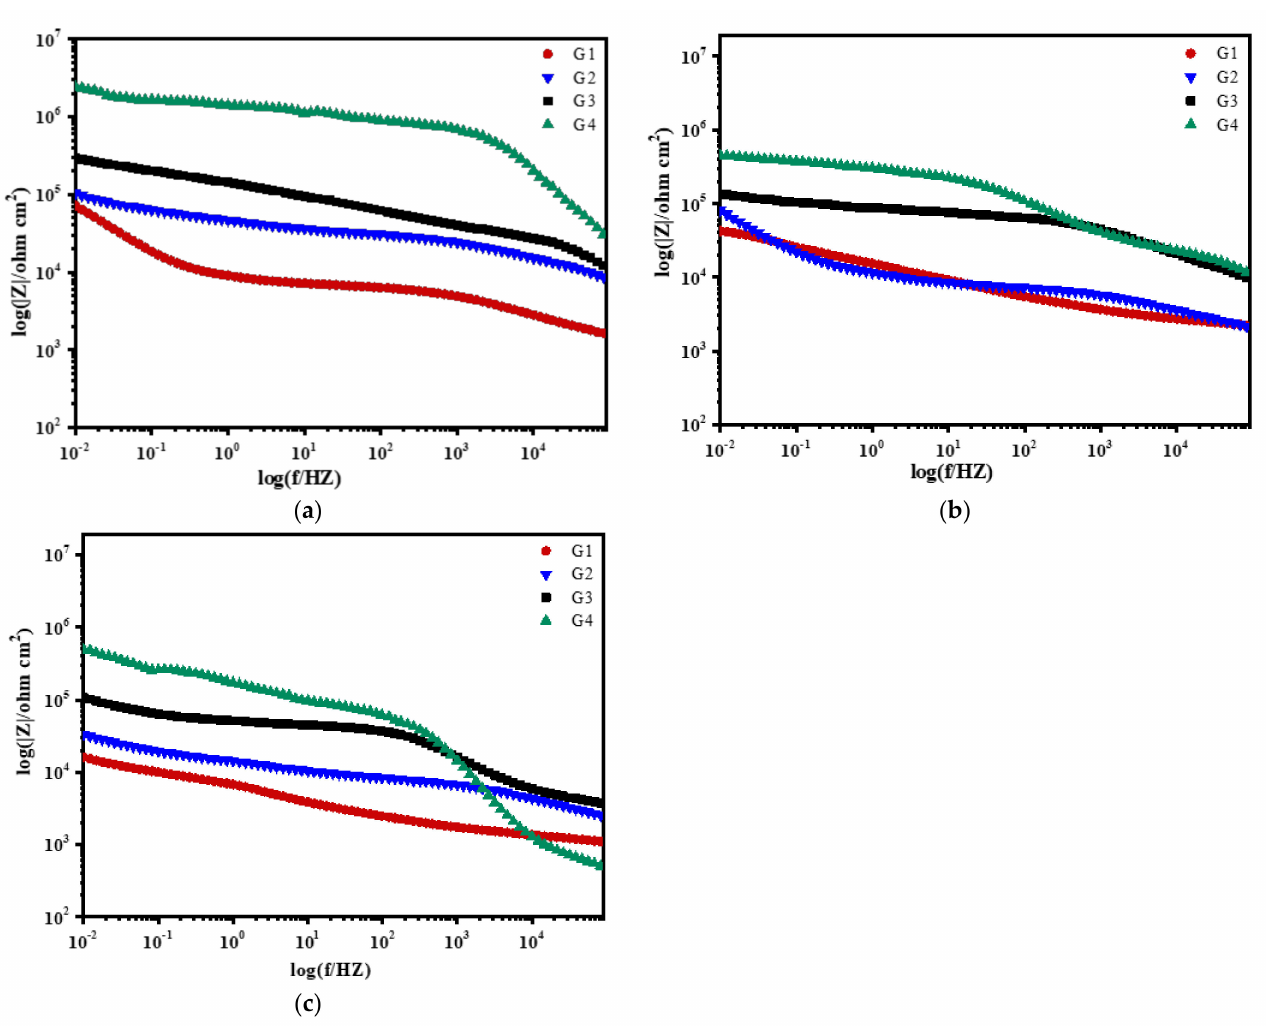
Figure 10. Each coating’s Bode pattern for immersion for 45 days: ( a ) 20% Seawater; ( b ) 40% Seawater; ( c ) 60% Seawater.